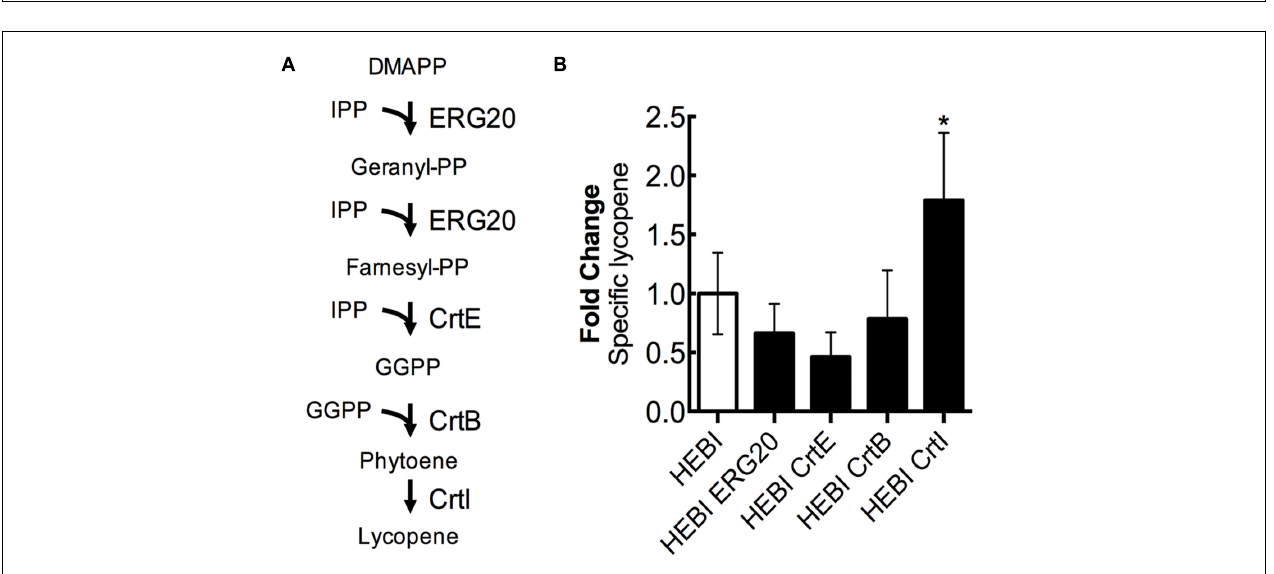
FIGURE 7 | Engineering the lycopene biosynthetic pathway. (A) Schematic representation of the lycopene biosynthetic pathway. (B) Relative specific lycopene production from strains with a single gene in the lycopene biosynthetic pathway overexpressed. Strains were grown for 4 days in 25 mL of YPD10 at 30 ◦ C in baffled shake flasks. Bars and error bars represent the mean and standard deviation, respectively, of biological triplicates. Statistical significance from the HEBI strain is indicated by “ ∗ ”. The HEBI strain produced 3.2 ± 0.9 mg lycopene/g DCW.